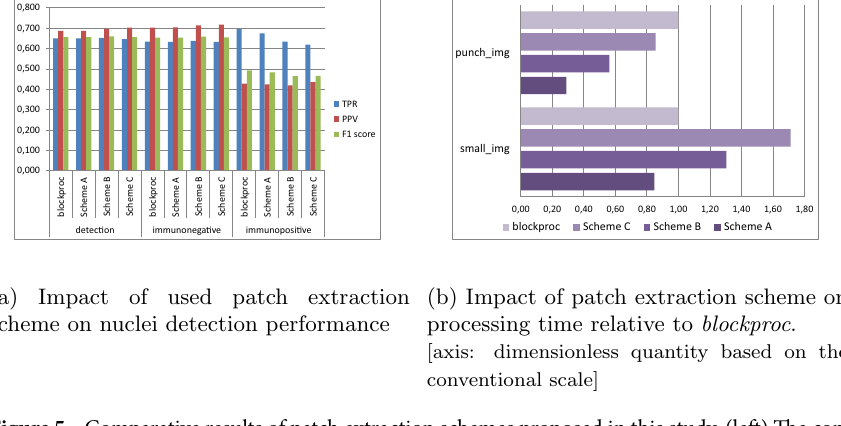
Figure 5. Comparative results of patch extraction schemes proposed in this study. (left) The comparison of detection performance metrics. (right) Time estimation relative to blockproc method. Two sizes of images were tested: punch_img (one core of TMA) of size 16,000 × 13,000 pixels and small_img (relatively small cropped image) of size 1000 × 1000 pixels.